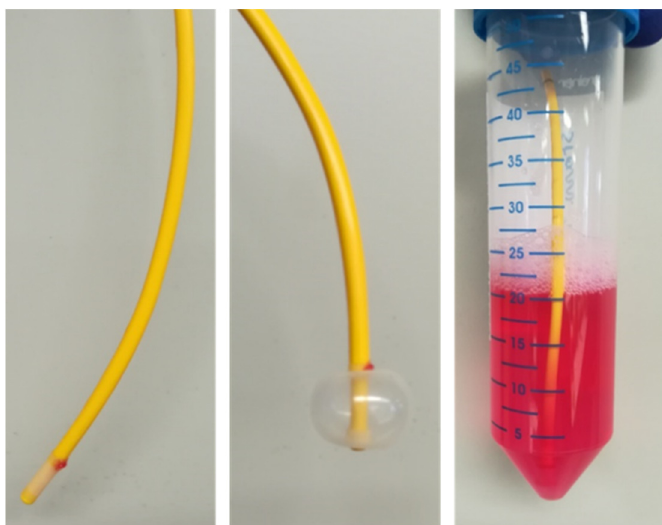
Figure 1. Swan-Ganz pulmonary arterial catheter with inflatable balloon at the tip of the catheter is collected in warm (37 °C) basal medium containing 0.2% cell growth supplement and transported collected in warm (37 ◦ C) basal medium containing 0.2% cell growth supplement and transported from the catheterization unit to the laboratory. from the catheterization unit to the